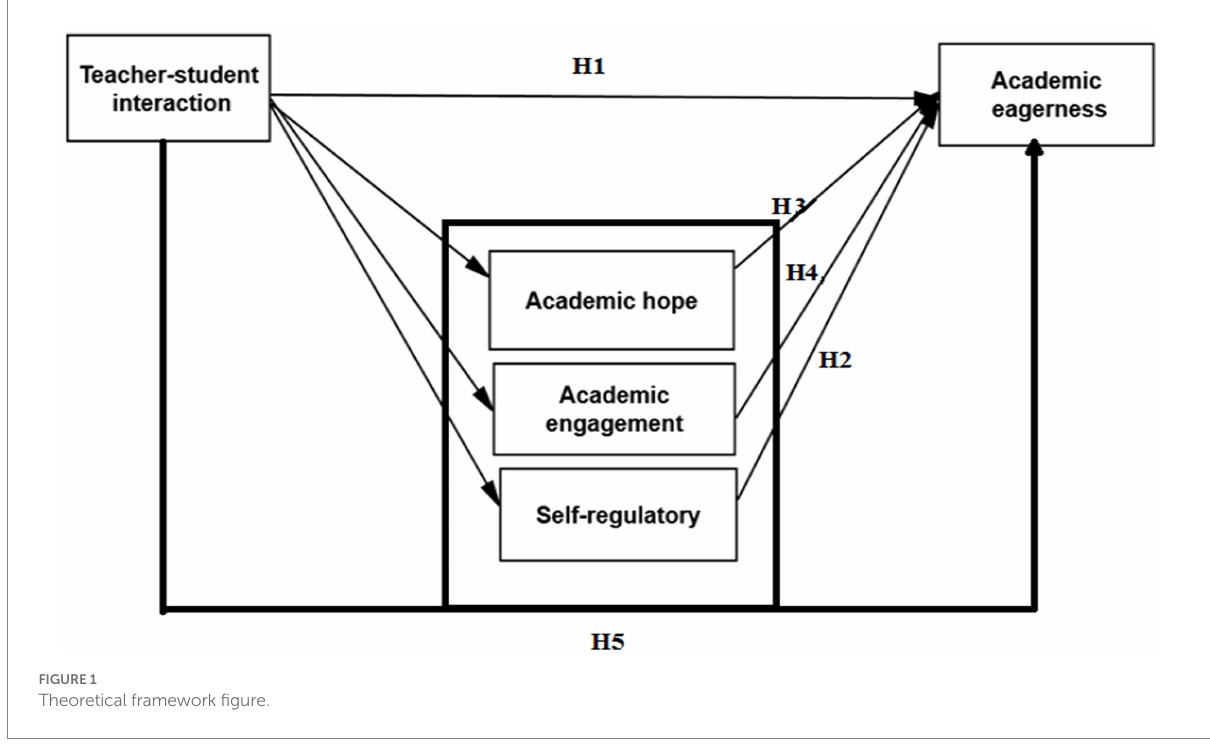
FIGURE 1 Theoretical framework